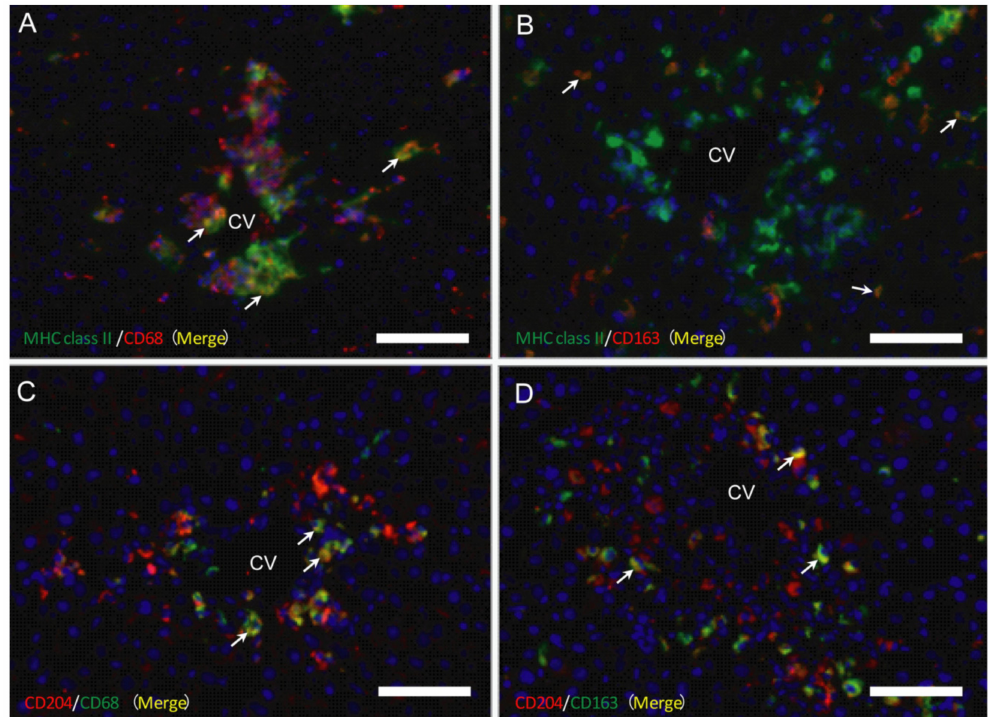
Figure 7. Double immunofluorescence with combinations of MHC class II / CD68 ( A ) and MHC class II / CD163 ( B ) on day 2, and CD204 / CD68 ( C ) and CD204 / CD163 ( D ) on day 3. Yellow color (arrows) indicates double-positive reactions. Blue is nucleus stained with 4’, 6-diamino-2-phenylindole (DAPI). CV, central vein. Bar = 40 µ